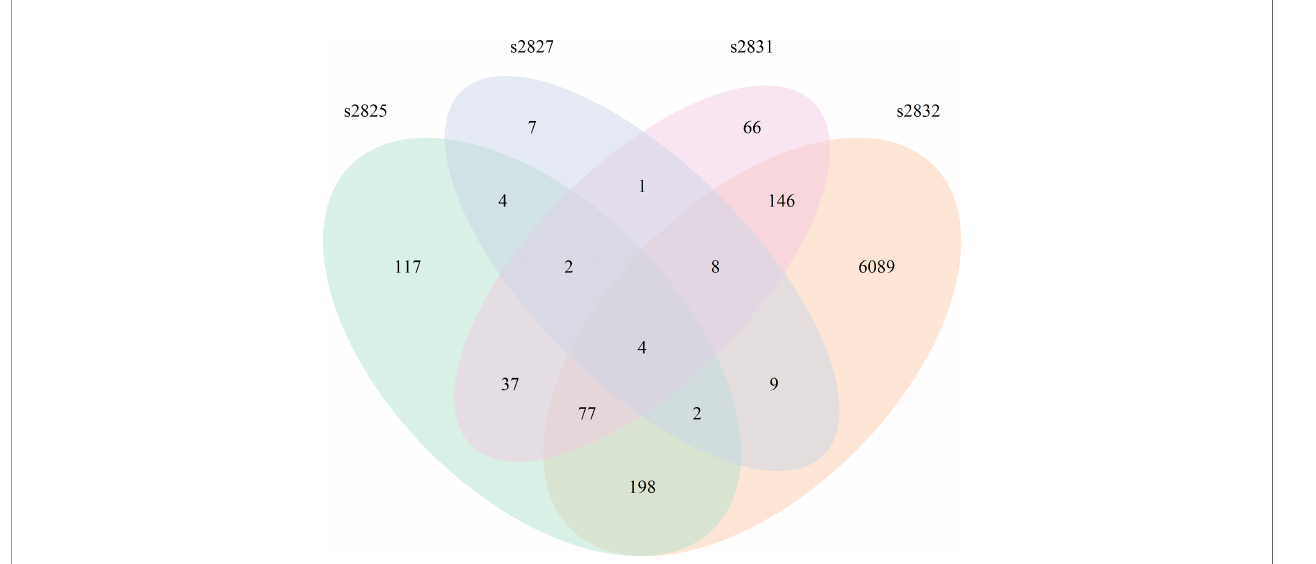
FIGURE 3 | Fusarium verticillioides response to Streptomyces at 2 h. Venn diagram showing the overlap of DEGs from all 4 F . verticillioides – Streptomyces dual-cultures at 2 h. TABLE 1 | Common differentially expressed genes at 2 h for all dual-cultures.